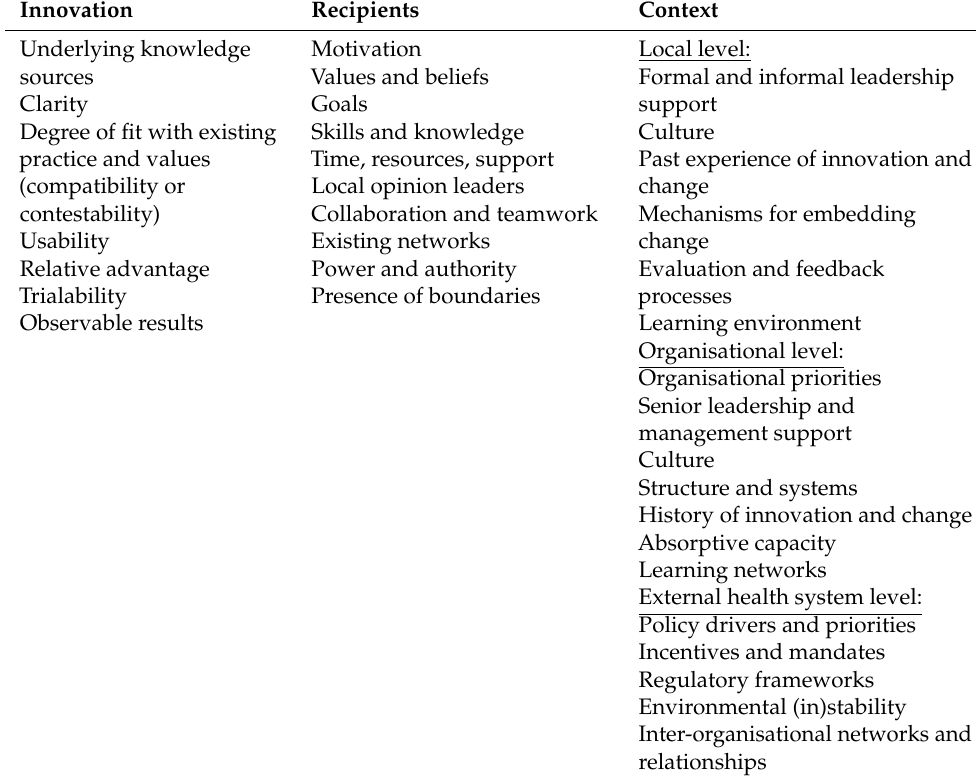
Table 1. Characteristics of i-PARIHS